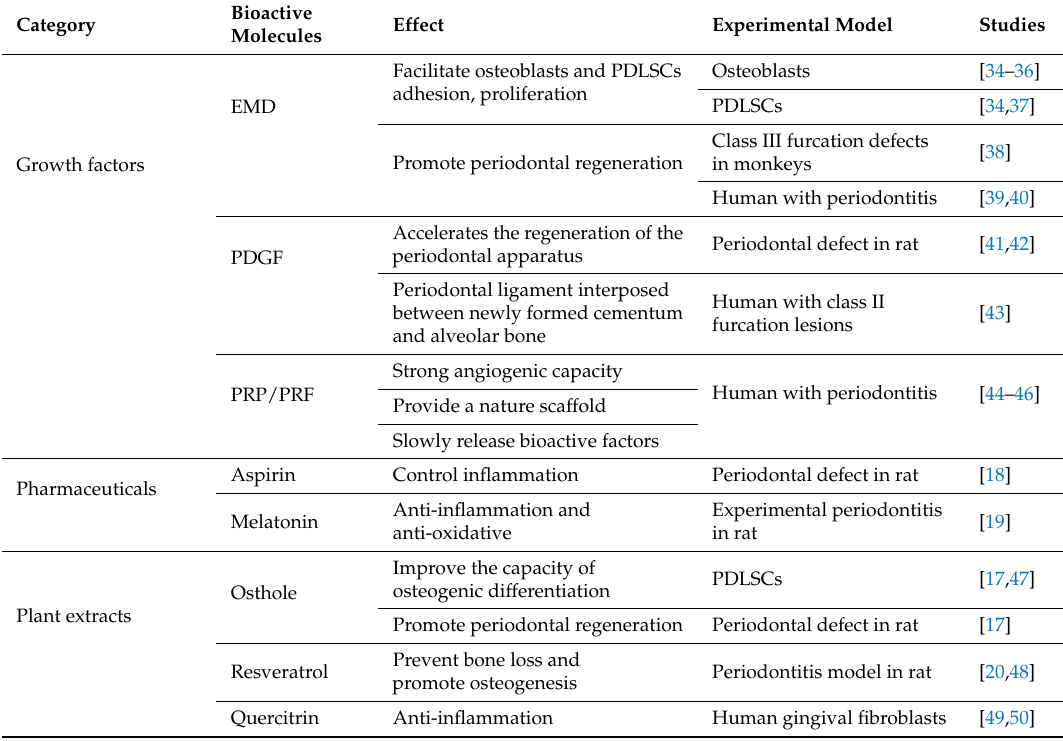
Table 1. Summary of the categories of bioactive molecules that are involved in periodontal